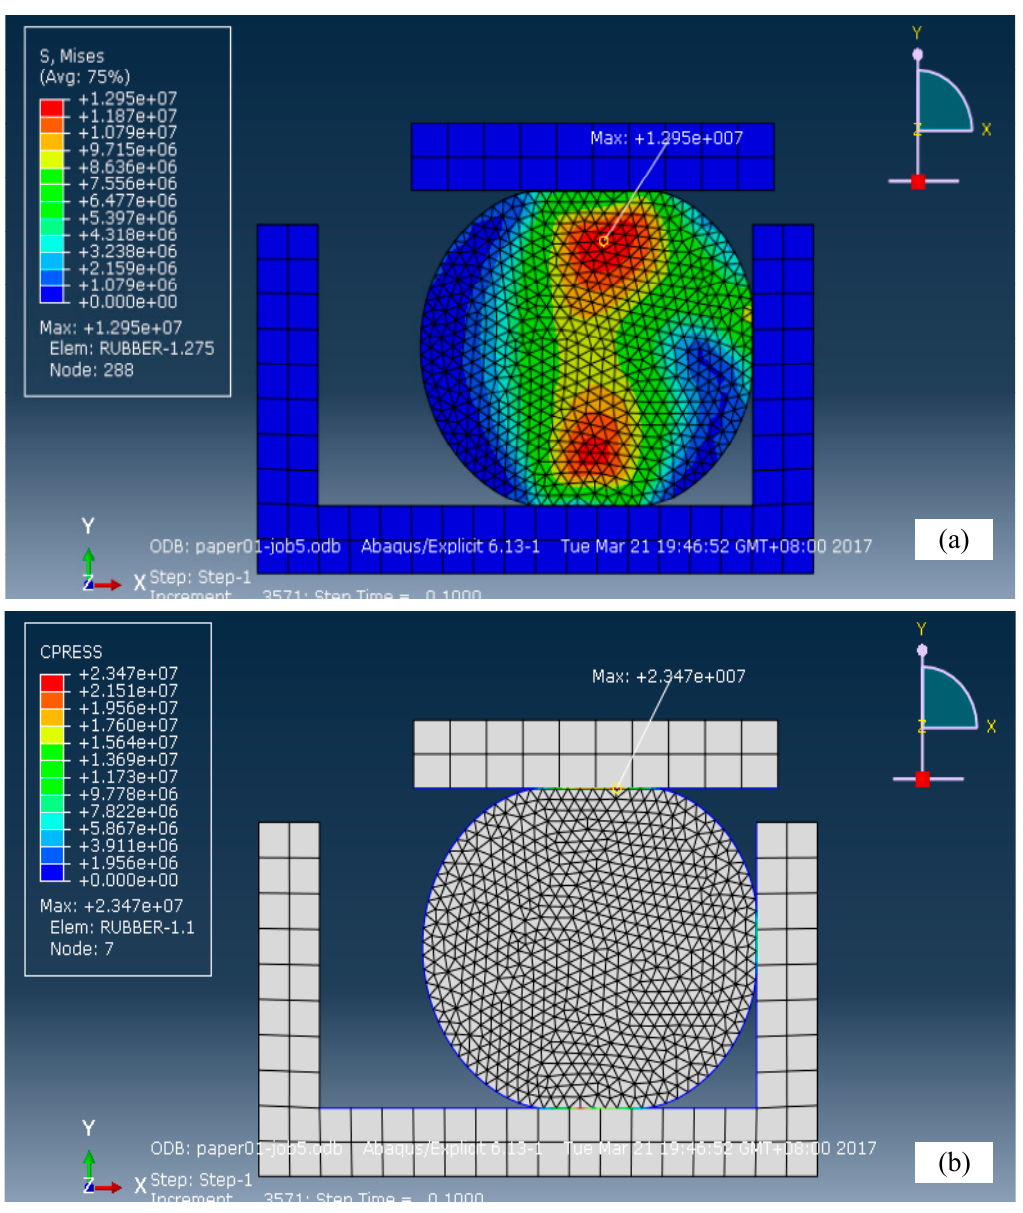
Figure 4. ( a ) Compressive stress and ( b ) contact stress distribution nephograms.